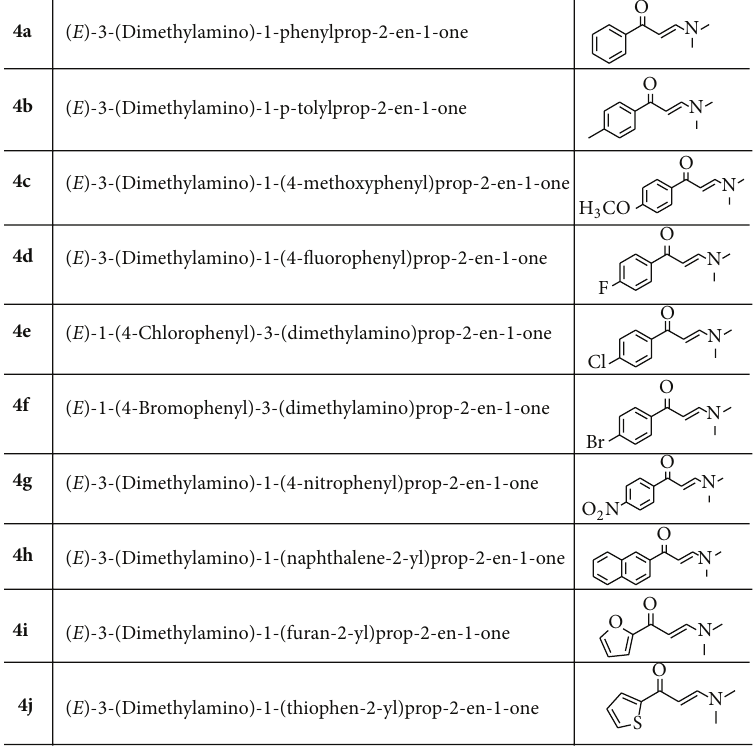
Figure 1: The structures of the selected enaminones 4a–j